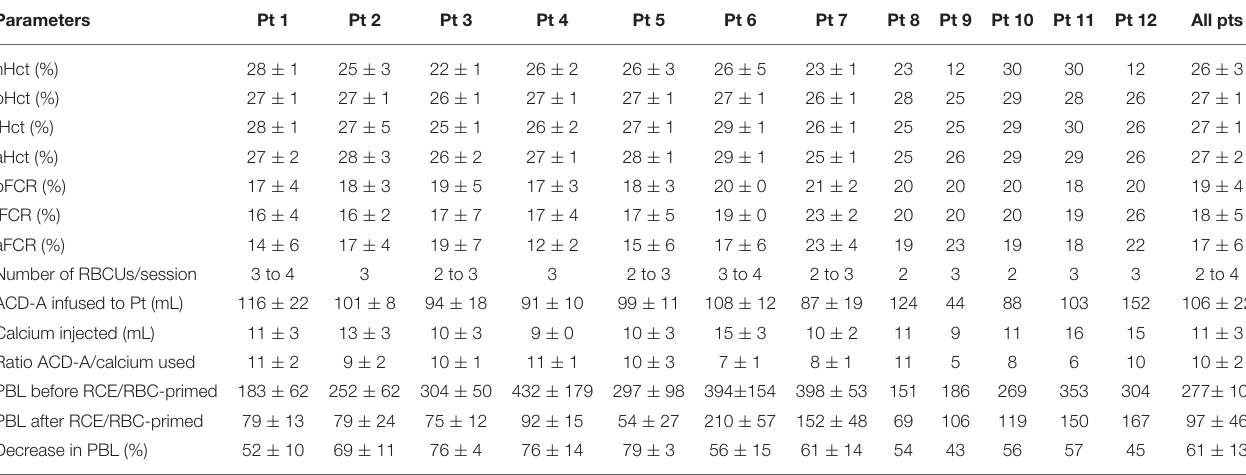
TABLE 3 | Biological results to assess performances of RCE/RBC-primed.